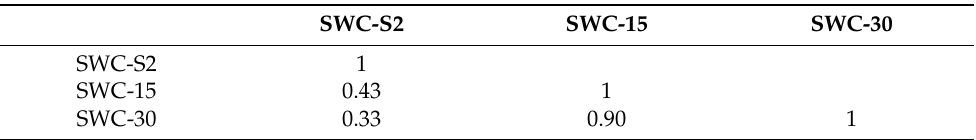
Figure 2. Changes in soil water content (SWC) at 15 and 30 cm depths measured by volumetric soil moisture sensors and SWC retrieved from Sentinel-2 (S2) images. Table 4. Correlation coefficients among SWC retrieved from S2 images (SWC-S2), SWC measured at 15 cm (SWC-15) and 30 cm